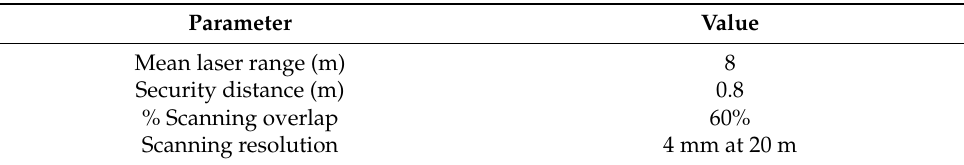
Figure 9. Optimal route followed by the unmanned ground vehicle (UGV) for data acquisition; ( a ) optimal route and scan points in the first study case; ( b ) resulting Faro point cloud of the first study case; ( c ) optimal route and scan points of the second study case; ( d ) resulting Faro point cloud of the second study case.